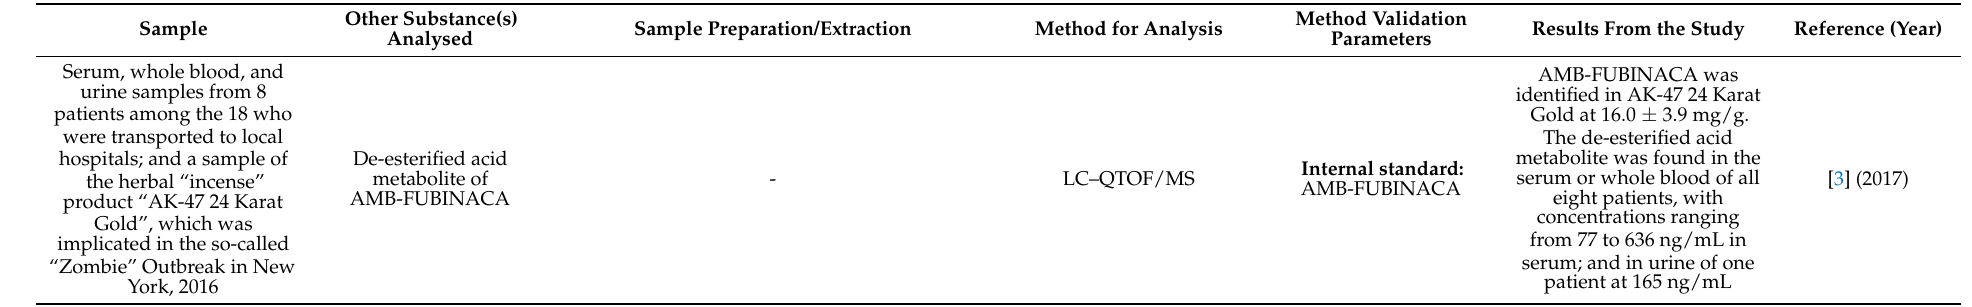
Table 3. Analytical techniques for the identification and quantification of